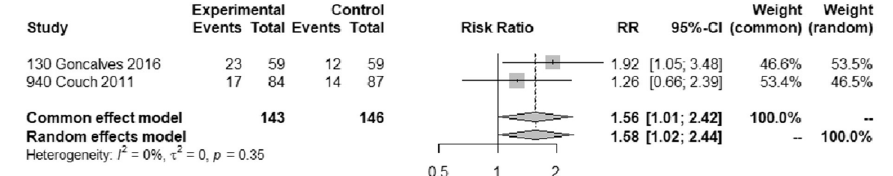
Fig. 4 Sensitivity analysis of analysis for 50% or more reduction in monthly migraine days excluding a trial that reported on a 50% reduction in a migraine